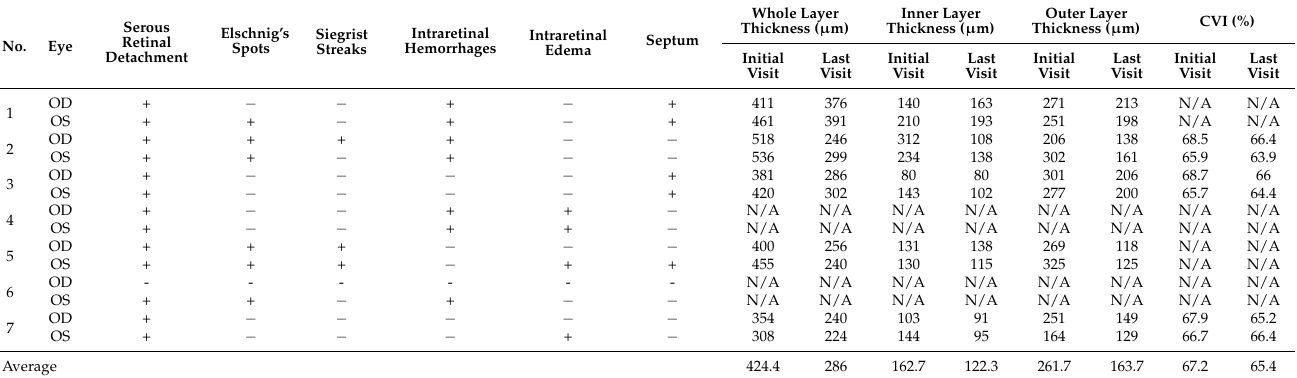
Table 2. Fundus findings and changes of choroidal